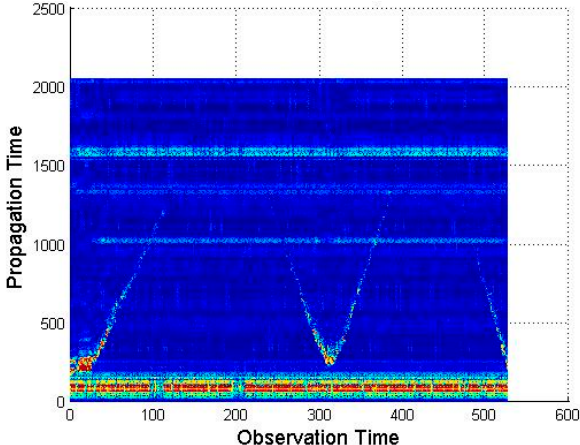
Figure 1. Raw data Radargram.